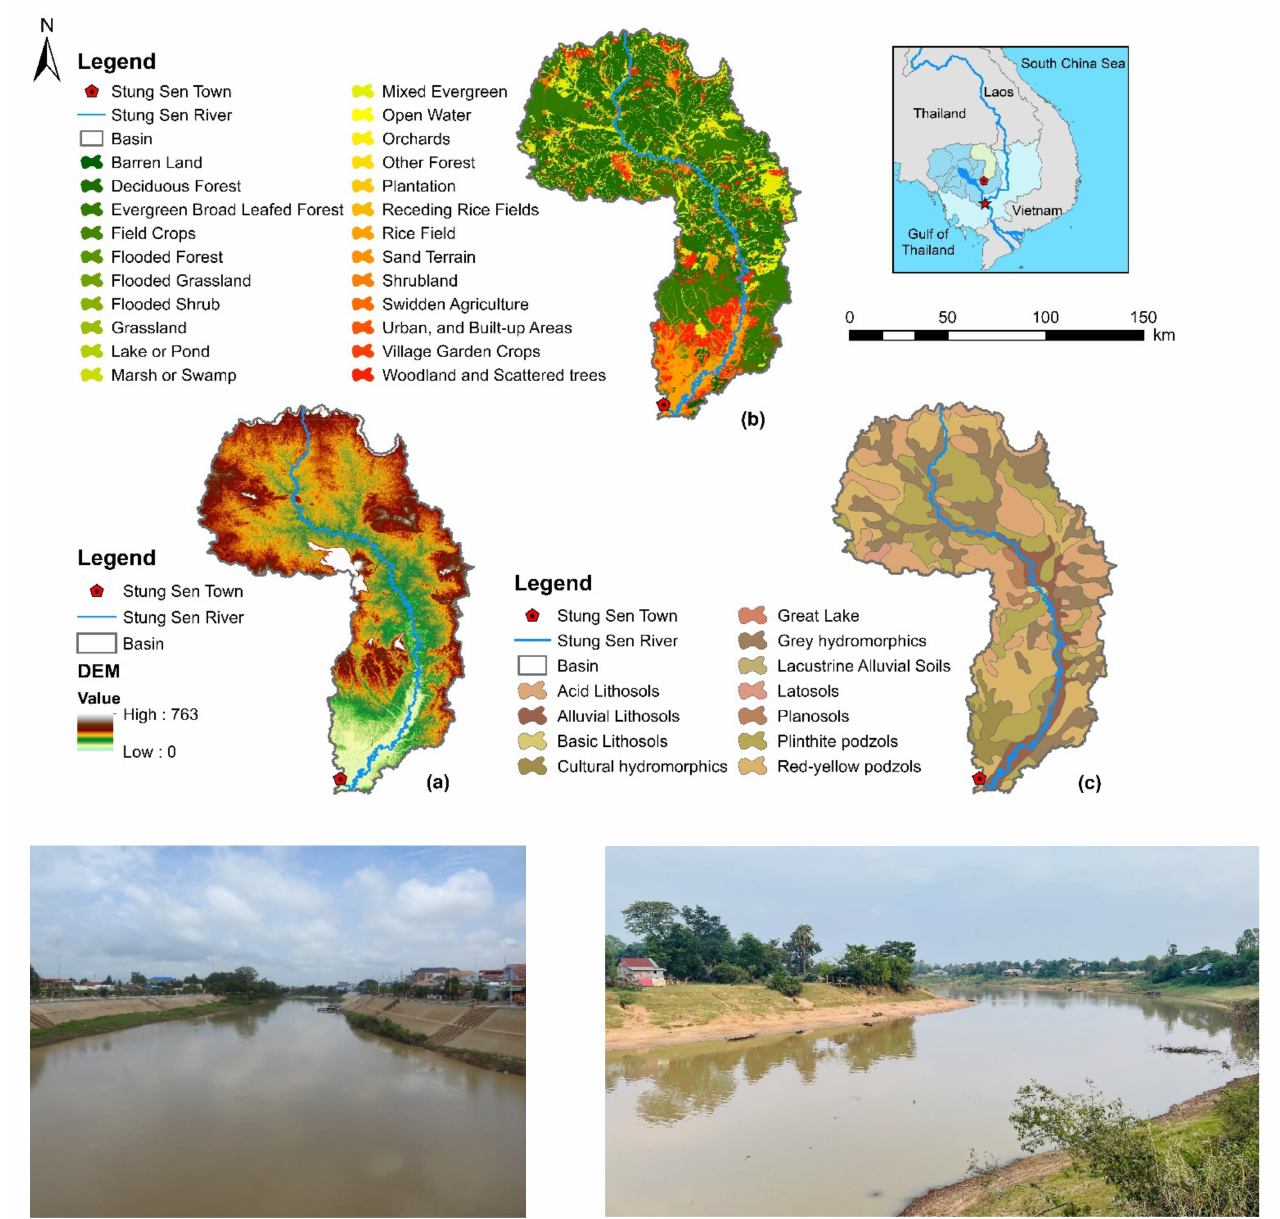
Figure 1. Sen River Basin ( a ) Digital Elevation Model (DEM), which is the largest tributary of Tonle Sap Lake Basin, ( b ) Land use distribution, and ( c ) Soil type distribution and field photo of streamflow analyzed location at Stung Sen Town at the outlet of the Sen